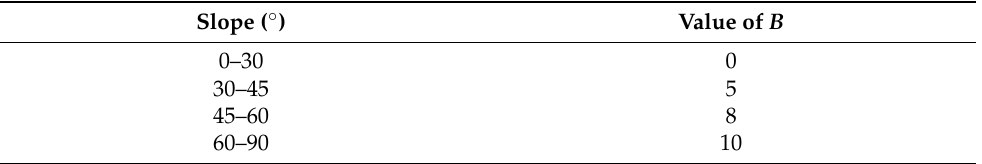
Table 1. Criterion for selecting the value of B in Equation (1).